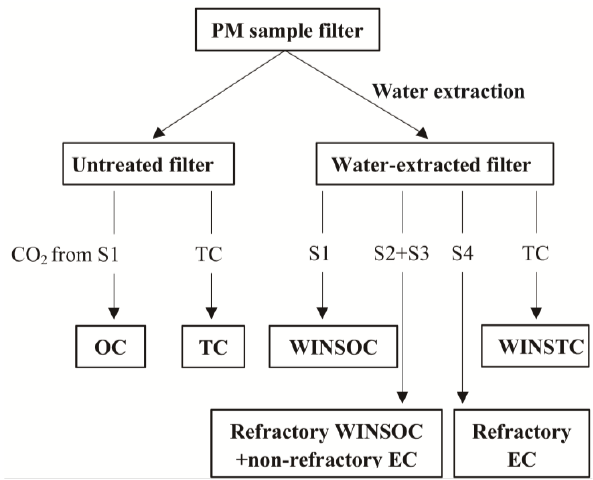
Fig. 2. Fig. 2. Separation scheme of the different carbon fractions for 14 C measurement. CO 2 is recovered during the desired peak in the in- dividual step (e.g. S1, S2, S3 and/or S4) with the present protocol (Swiss 4S). Step TC means that CO 2 is recovered from all steps without